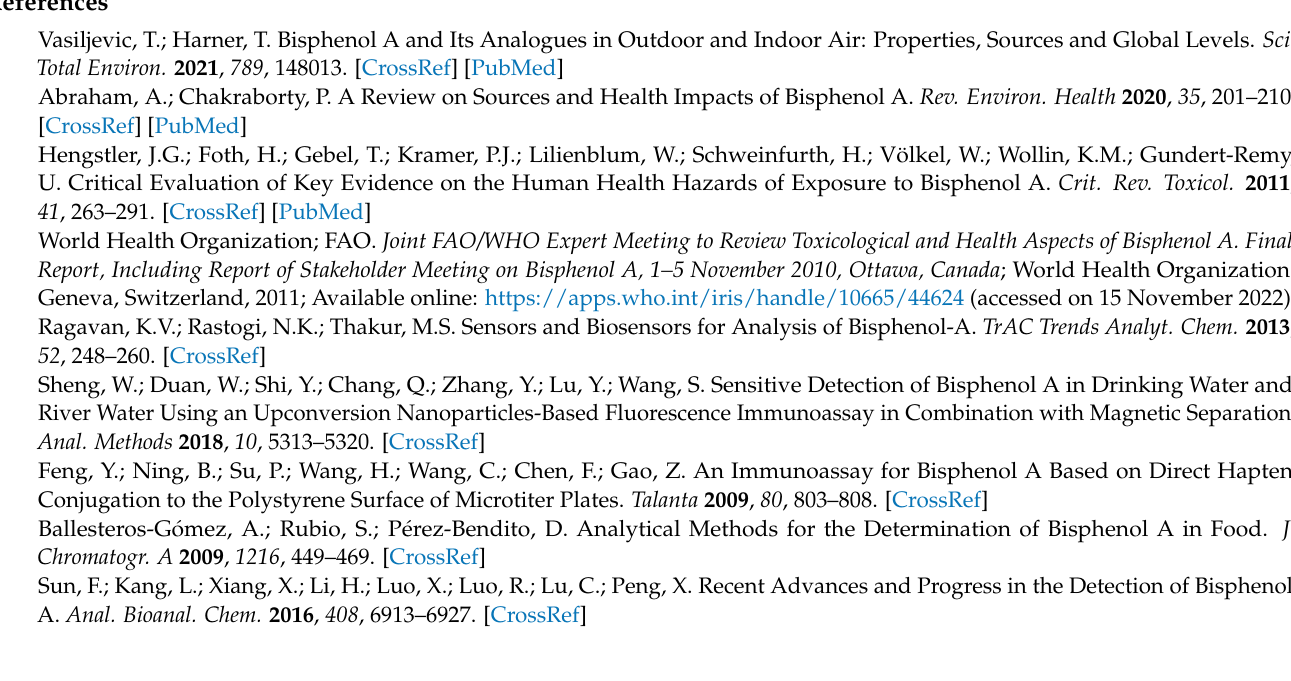
different AgNPs, Figure S1: Experimental Raman spectrum of the BPA solid and that theoretical at CAM-B3LYP/def2-TZVPP level of calculation. The calculated wavenumbers are not scaled, Figure S2: Vectorial representation of the vibrational motions corresponding to the two strongest SERS bands. Wavenumbers calculated at CAM-B3LYP/def2-TZVPP level, Figure S3: Optimized CAM-B3LYP/def2-TZVPP structures of isolated (a) BPA and (b) BPA(OH), Figure S4: Optimized CAM-B3LYP/def2-TZVPP structures of (a) Ag 2 -BPA and (b) Ag 2 -BPA(OH) complexes in which silver atoms are coordinated through the oxygen atoms, Table S2: TD-CAM-B3LYP/def2-TZVPP excitation energies ( ∆ E) and oscillator force (f) at the Franck-Condon point corresponding to the first ten singlets of isolated BPA and BPA(OH), Table S3: TD-CAM-B3LYP/def2-TZVPP excitation energies ( ∆ E) and oscillator force (f) at the Franck-Condon point corresponding to the first ten singlets of the different Ag 2 -BPA and Ag 2 -BPA(OH) complexes coordinated through the oxygen atoms and their corresponding charges transferred ( ∆ q), Table S4: TD-CAM-B3LYP/def2-TZVPP excitation energies ( ∆ E) and oscillator force (f) at the Franck-Condon point corresponding to the first ten singlets of the different Ag 2 -BPA and Ag 2 -BPA(OH) complexes coordinated through one face of the aromatic ring and their corresponding charges transferred ( ∆ q), Figure S5: CAM-B3LYP/def2-TZVPP resonance Raman spectra to the first charge transfer (CT) state of (a) Ag 2 -BPA and (b) Ag 2 -BPA(OH) complexes in which silver atoms are coordinated through internal and external ring face. The insets show the resonance Raman spectra to the first plasmon-like (PL) state. Reference [37] is cited in the supplementary